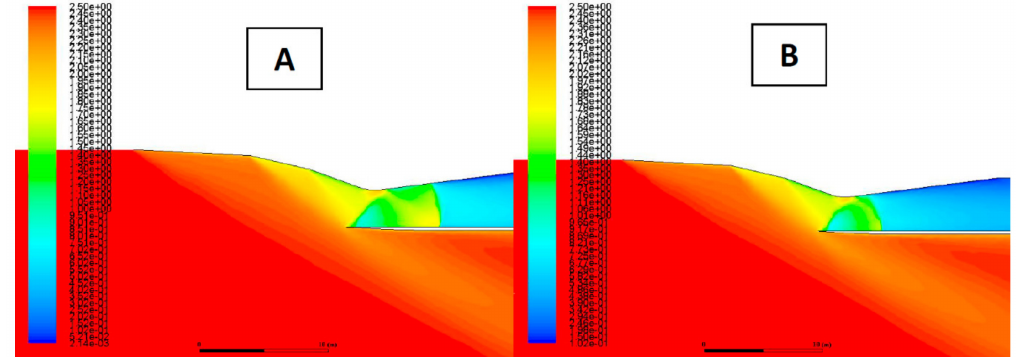
Figure 3. Mach number contours for the optimised inlet for Mach 2.5. for configurations ( A , B ).